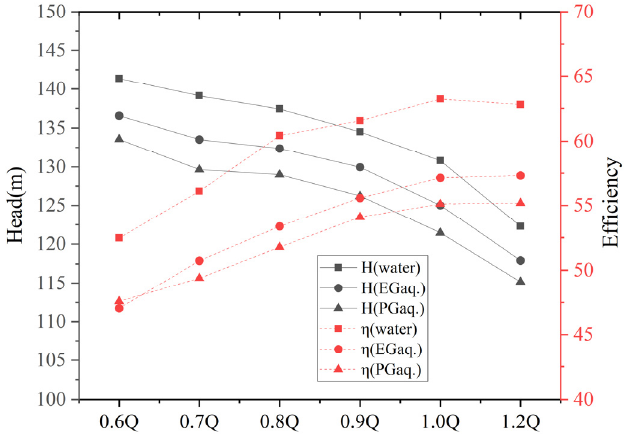
Figure 11. Characteristic curves of the pump with splitter blades.